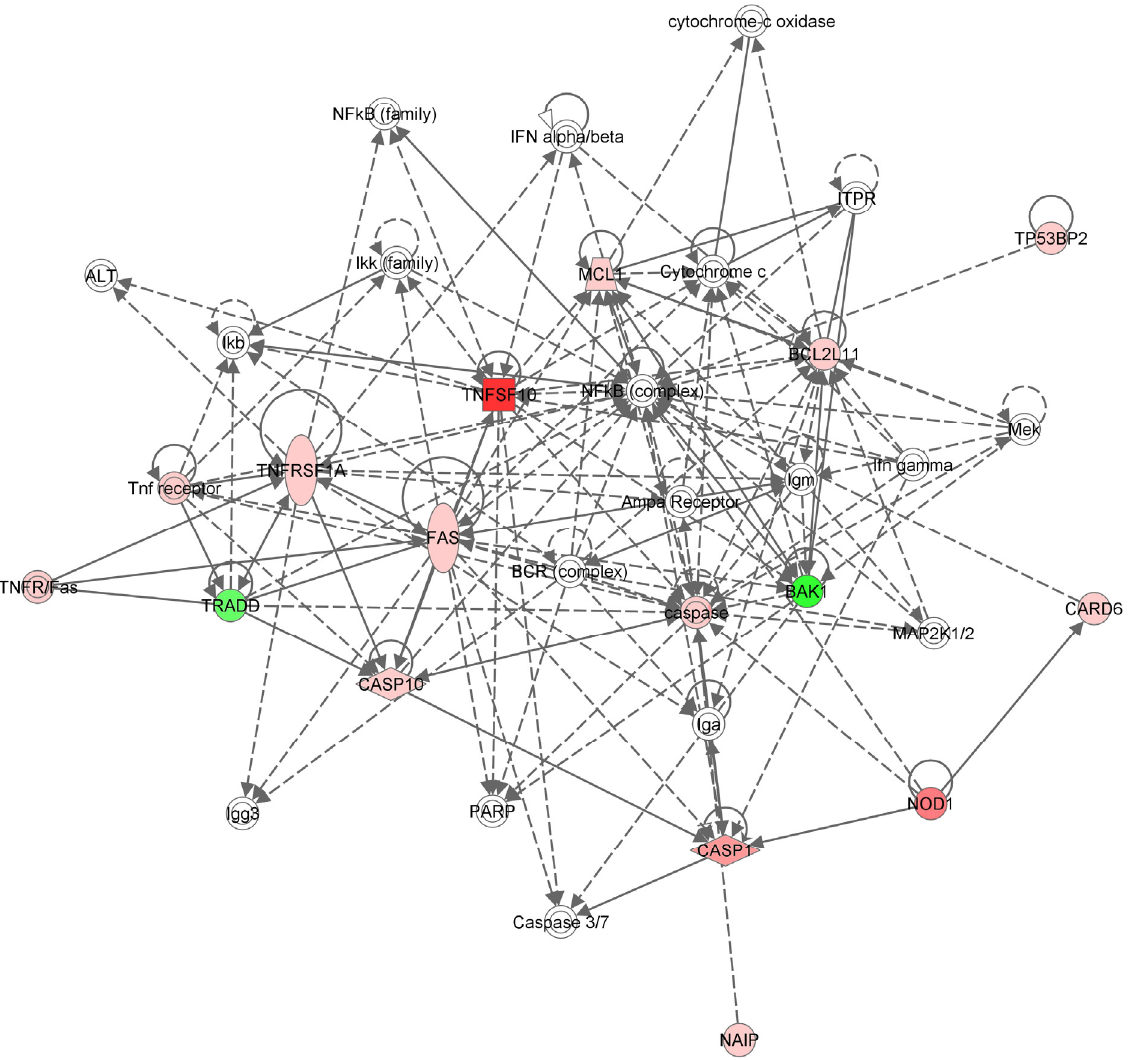
Figure 3. The apoptosis canonical network associated with the 15 genes involved in triple negative breast cancer TNF- α gene silencing generated by Ingenuity that marks the relationship between the known genes involved in